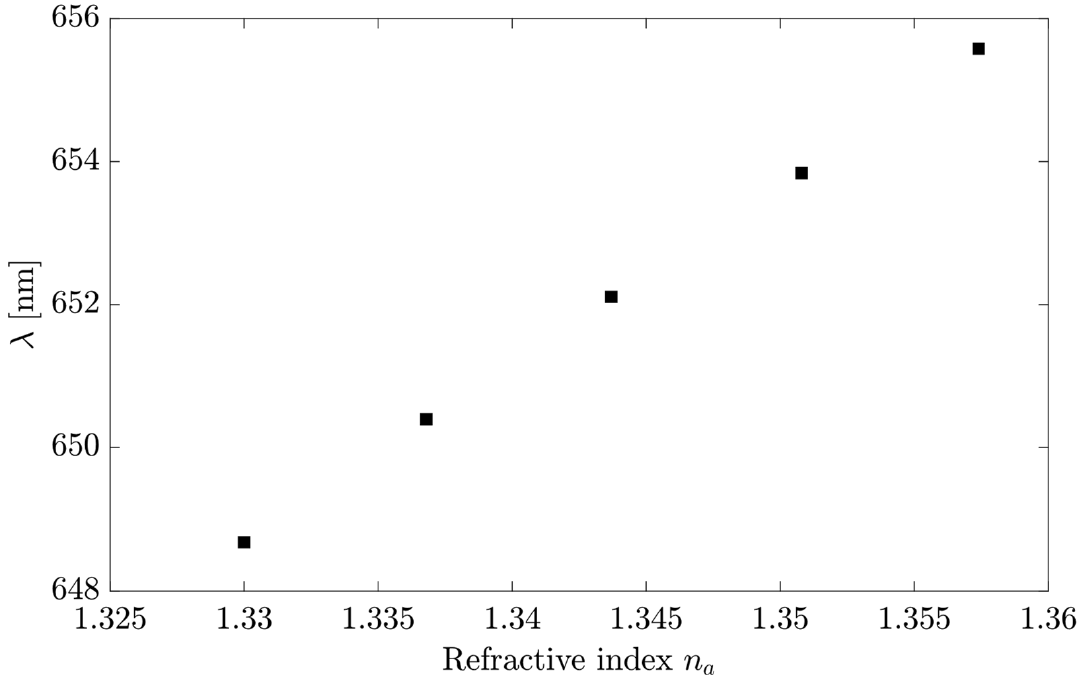
Figure 14. The LRSPP wavelength shift versus the refractive index of different glycerol concentrations for region II.